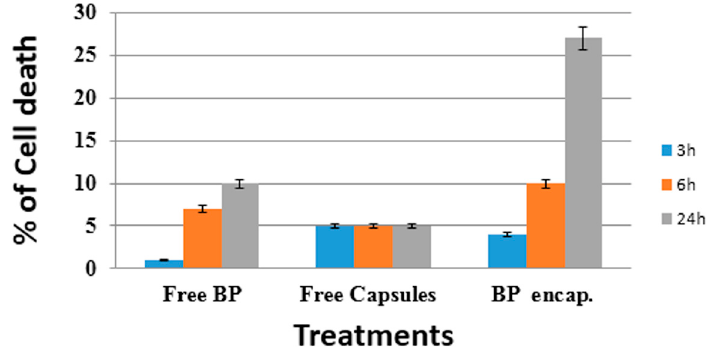
Figure 8. Trypan blue spectrophotometrical viability analysis against HLF cells. Percentage of dead cells upon increasing time (3–6–24 h) after treatment with free HPLPNC, free BrPA and encapsulated BrPA are reported. Data showed is an averaged value of three successive measurements with standard deviation (S.D.).